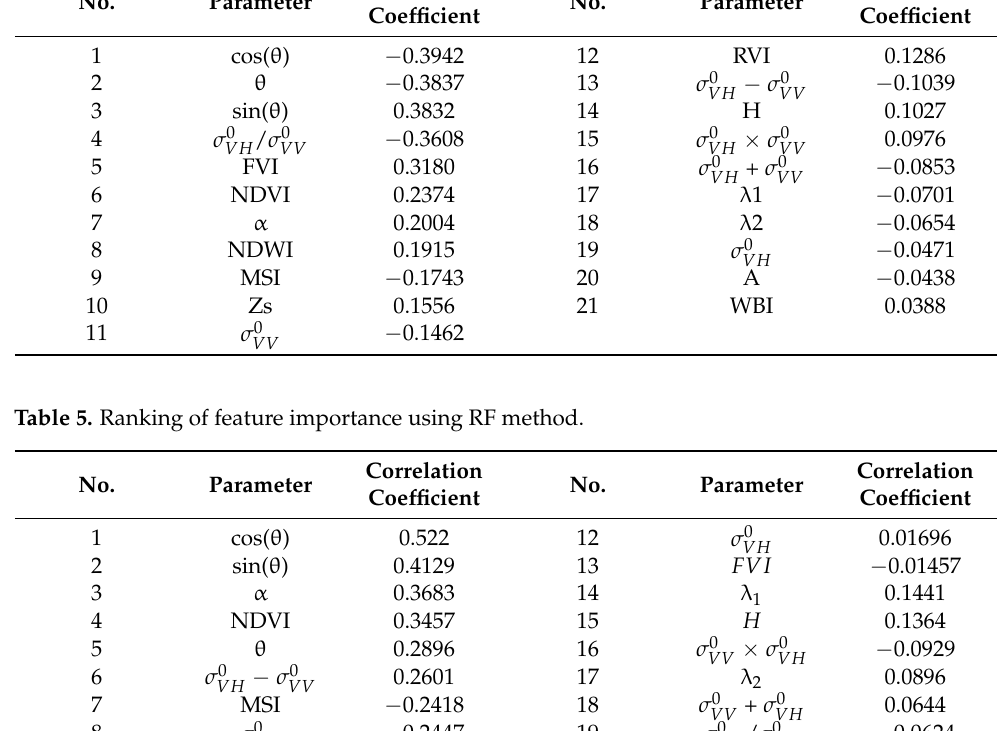
Table 4. Ranking of feature importance using the Pearson correlation analysis method. No.